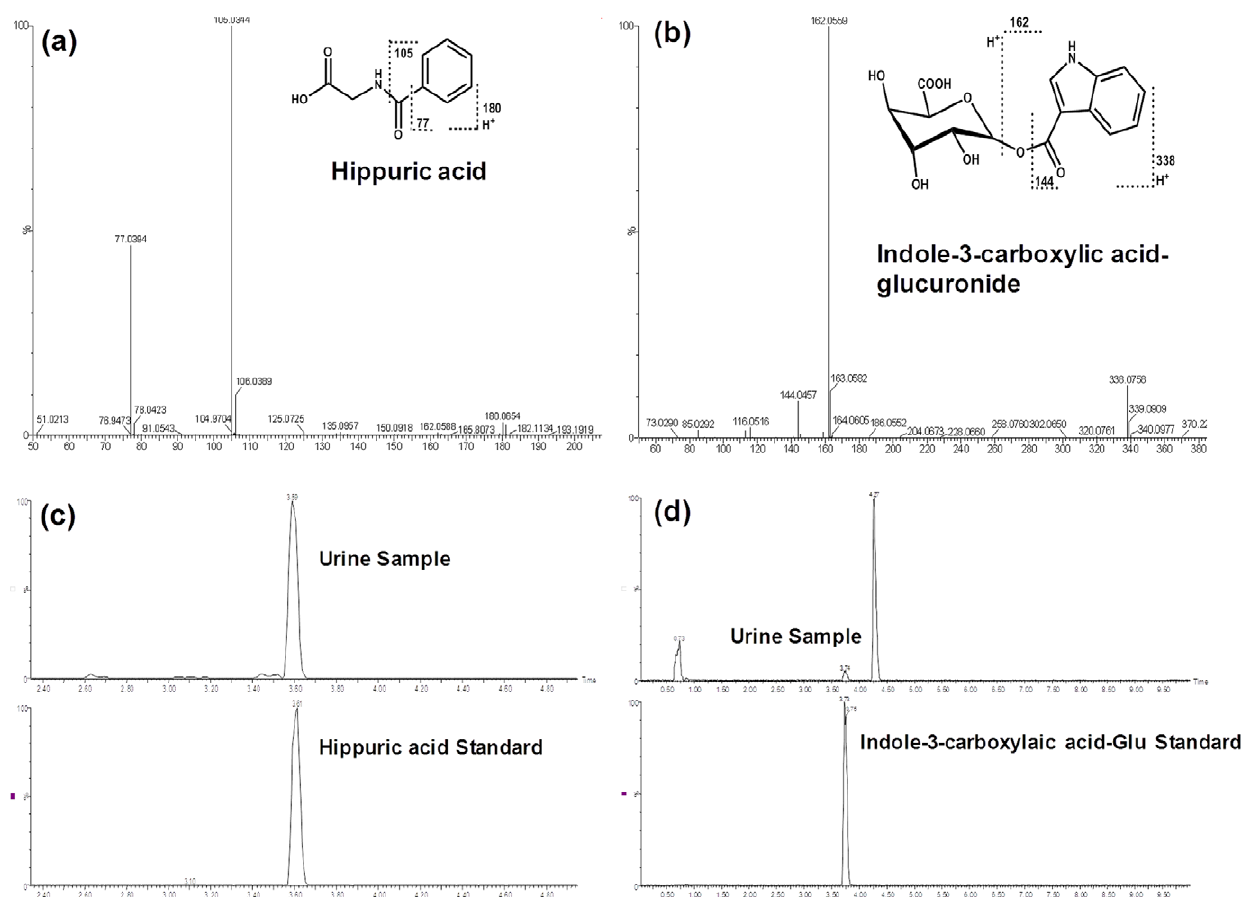
Figure 7. Oatp1a1-null mice had higher hippuric acid, but lower indole-3-carboxylic acid-glucuronide in urine than WT mice. Structural elucidations were performed based on accurate mass measurement and MS/MS fragmentations of hippuric acid (a) and indole-3-carboxylic acid-glucuronide (b) in urine of WT and Oatp1a1-null mice. By comparison of the retention time in the same MS/MS chromatograph window between authentic standards and urine samples, hippuric acid (c) and indole-3-carboxylic acid-G (d) were confirmed. The authentic standard indole-3- carboxylic acid-glucuronide (indole-3-carboxylic acid-G) was enzymatically synthesized from indole-3-carboxylic acid.